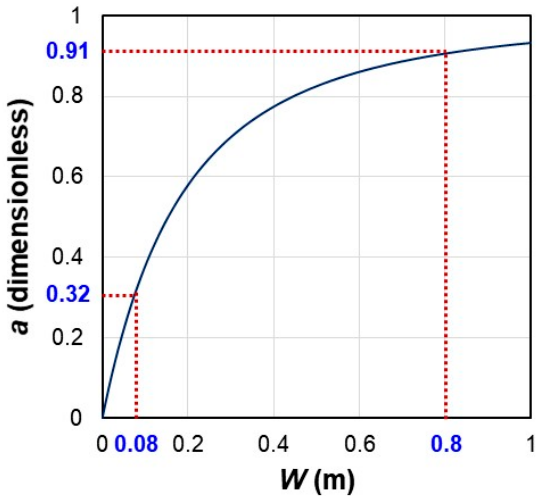
Figure 2. Relationship between the weir width ( W ) and conceptual parameter representing the drainage capacity ( a ).